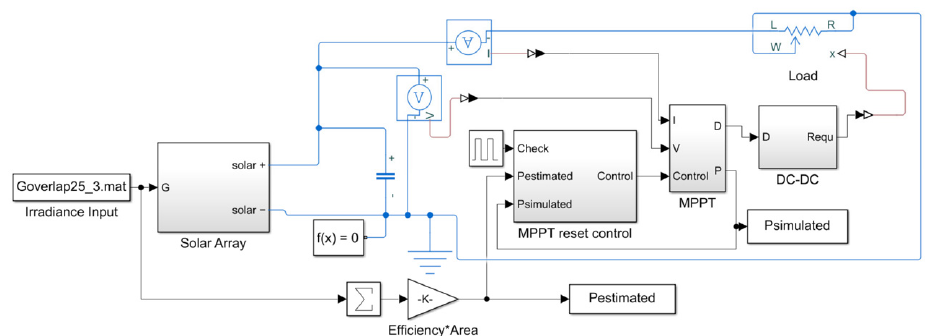
Figure 5. Model of energy